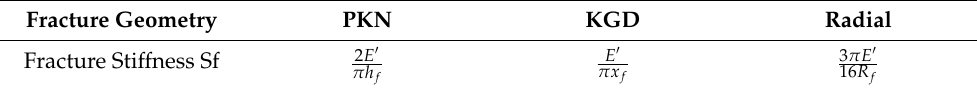
E (cid:48) 3 π E (cid:48) π x f 16 R π h f